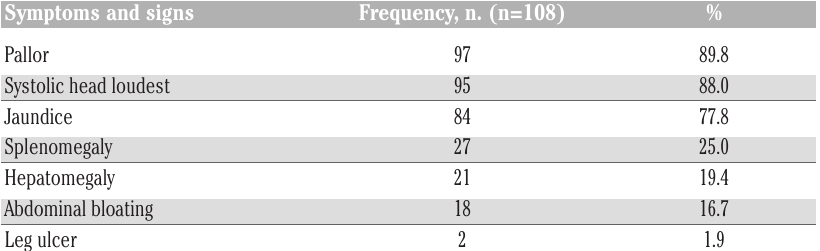
Table 2. Presenting features and physical findings of 108 children with sickle cell